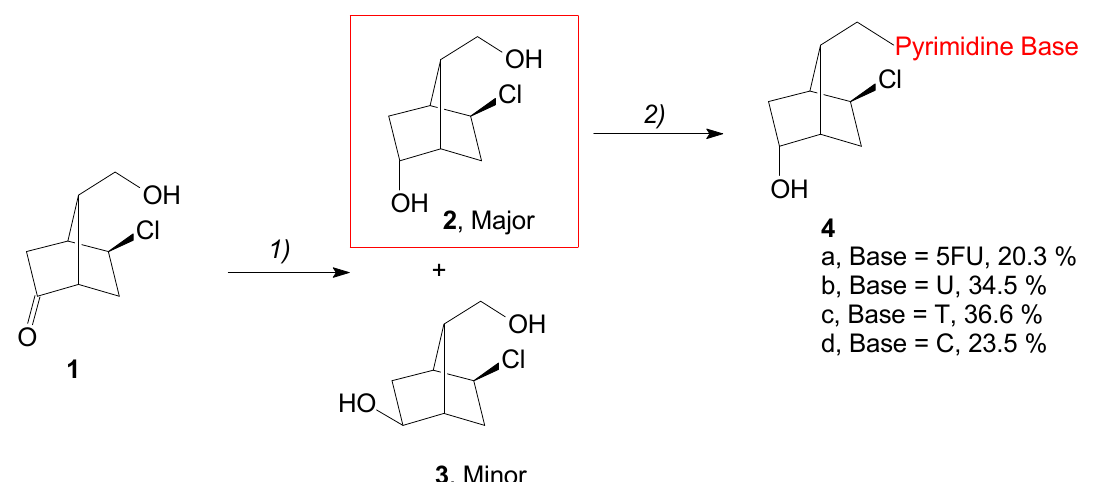
Scheme 1. Synthesis of pyrimidine N ′ -homocarbanucleoside analogs 4a – 4c : 1) 1 , NaBH 4 , MeOH, − 16 °C